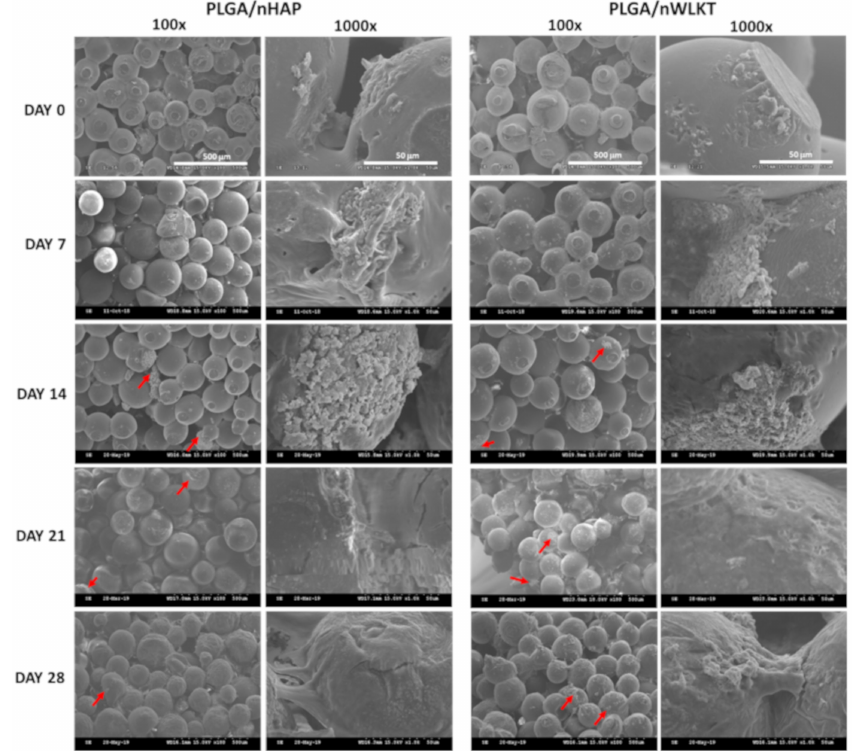
Figure 4. Assessment of cell morphology in PLGA / nHAP and PLGA / nWKLT microsphere sca ff olds on day 0, 7, 14, 21, and 28 through scanning electron microscopy (SEM) at 100 × (bar = 500 µ m) and 1000 × (bar = 50 µ m) magnification. The red arrows indicate mineralized